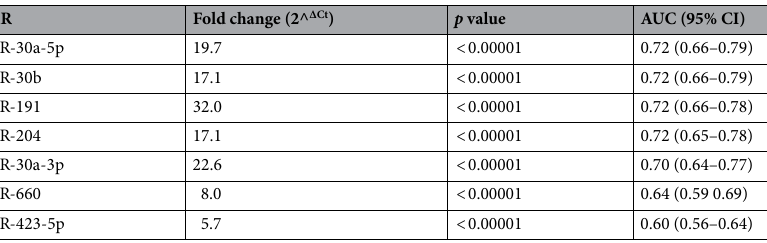
Table 1. Diagnostic performance of the seven microRNAs in all causes of AKI (NOAKI vs. AKIN2/3). Diagnostic performance of the seven microRNAs that distinguished AKI in all poisoning was assessed using normalized Ct values. p values represent Mann–Whitney-U between NOAKI (n = 57) versus AKIN2/3 (n = 94).